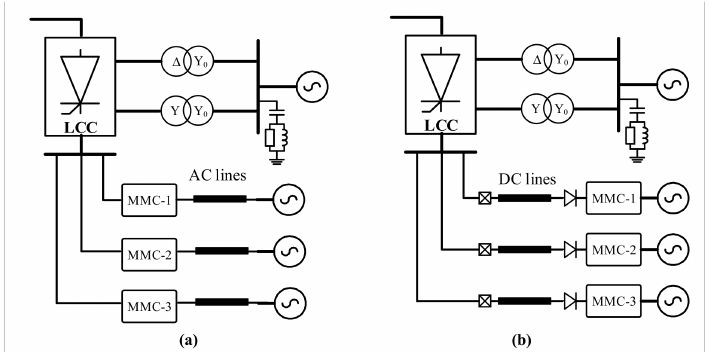
Figure 4. The difference between the concentrated access and the distributed access. ( a ) The diagrammatic sketch of the concentrated access. ( b ) The diagrammatic sketch of the distributed access.